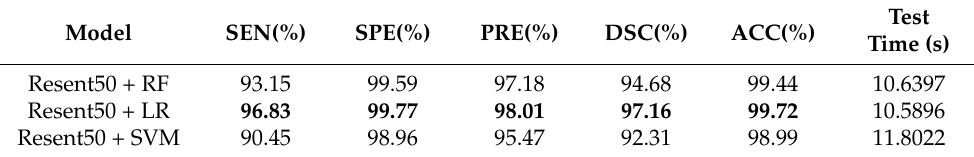
Table 7. The performance evaluation for ResNet50 combined with different classifiers.